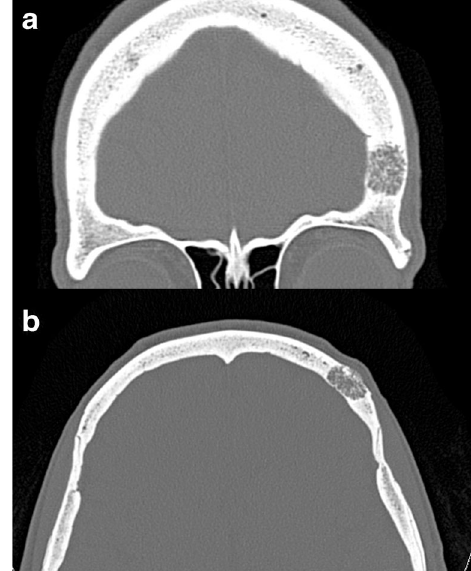
Fig. 5 Intraosseous haemangioma (IH). Coronal ( a ) and axial ( b ) reformats of a CT scan with bone window indicate a left frontal expansive lesion with thin margins and intralesional spicules, radiating from a common centre, which erodes the outer layer of the skull, with relative sparing of the inner